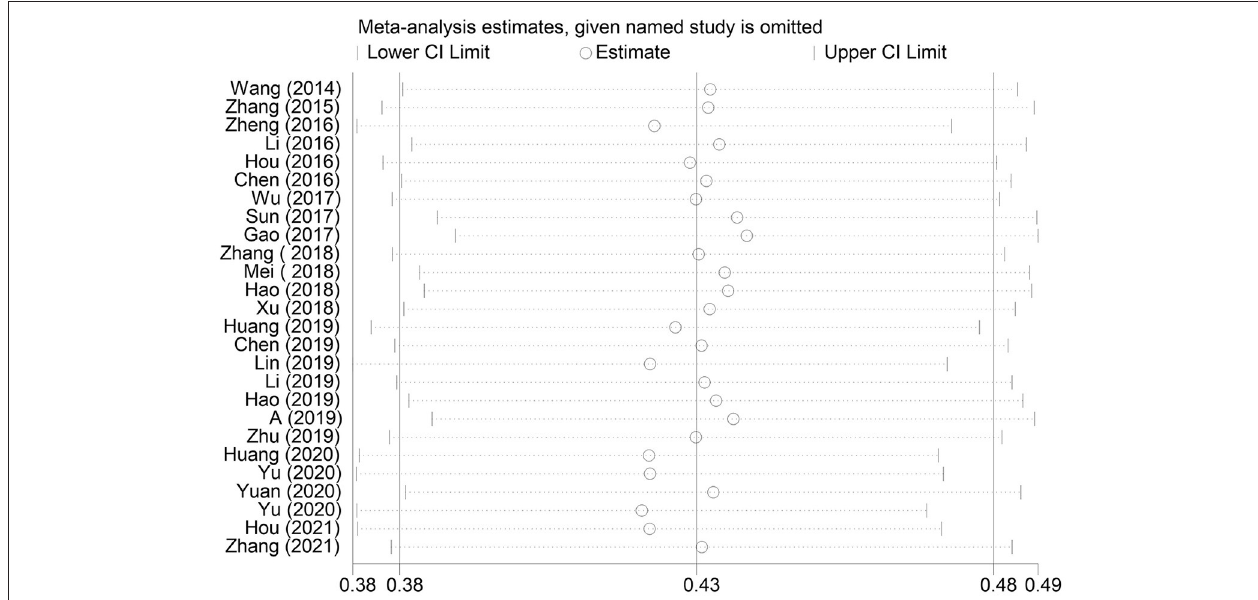
FIGURE 10 | Sensitivity analyses of the 26 studies included in the meta-analysis.